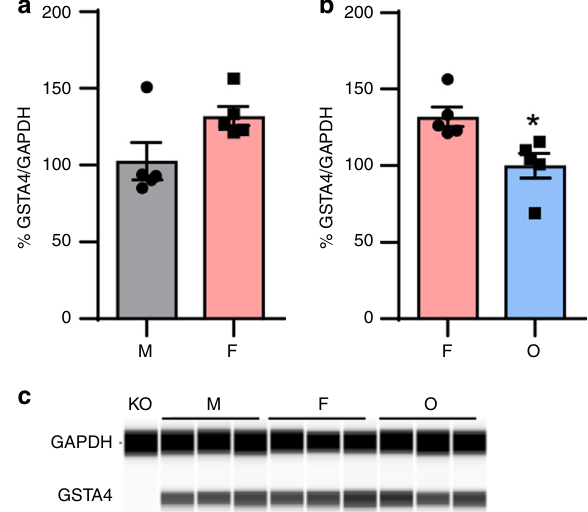
Fig. 8 Assessment of GSTA4 protein levels in the inner ears of CBA/CaJ mice. a , c GSTA4 protein levels were measured in the inner ear tissues from male and female CBA/CaJ mice. n = 5. Error bars represent ± s.e.m. b , c GSTA4 protein levels were measured in the inner ear tissues from female and OVX CBA/CaJ mice. n = 5, * p < 0.05 vs. F (unpaired two-tailed Student t test). Error bars represent ± s.e.m. The relative protein levels were normalized to levels of GAPDH. The full-length blot is presented in the Source Data fi le. M: male, F: female, O: ovariectomized female. Source data